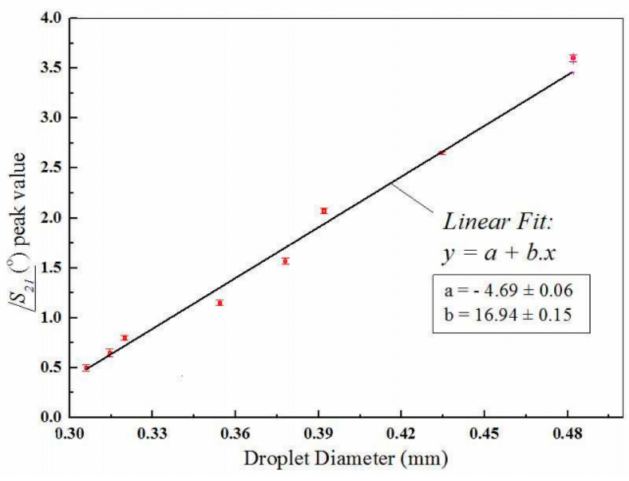
Figure 19. The measured peak value for different droplet diameters